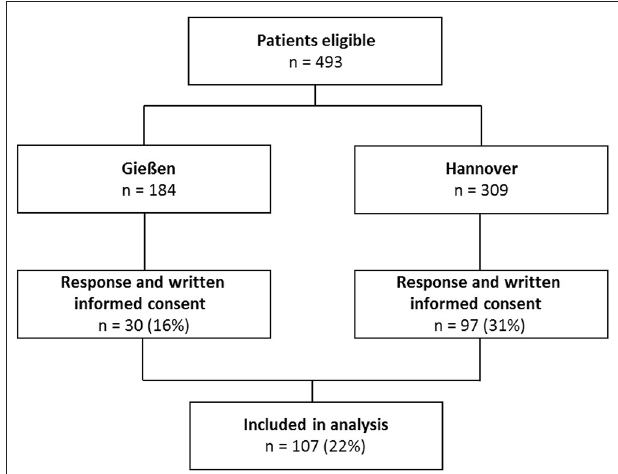
FIGURE 1 | Flowchart of patient